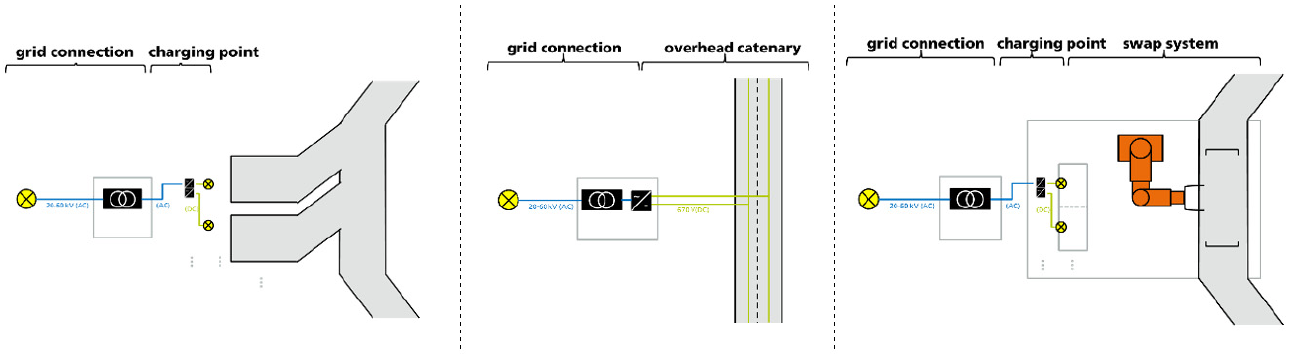
Figure 2. Structure for BEV, CV and BSV charging